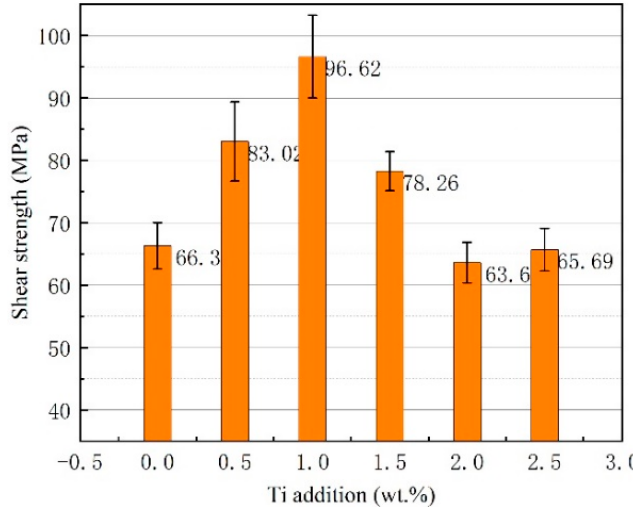
Figure 11. Shear strength of brazed joint as a function of Ti addition under the brazing temperature of 580 °C and brazing time of 30 min.